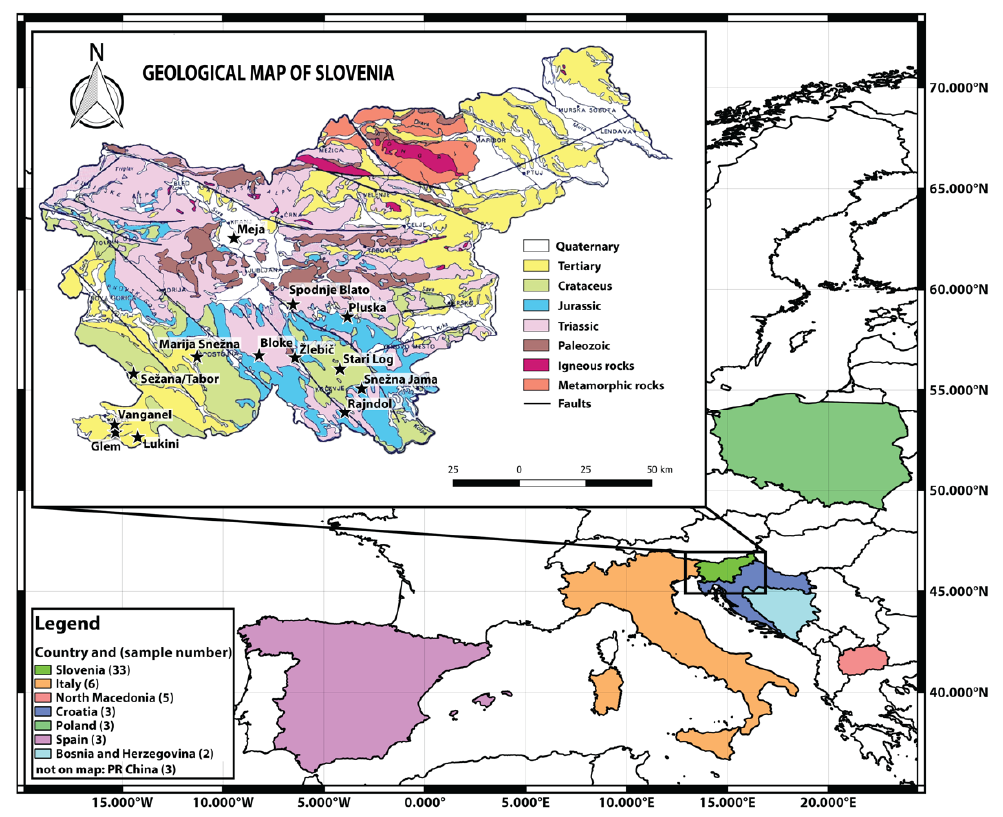
Figure 9. Geologic map of Slovenia (GeoSZ, 2013) with sample sites from the dataset (Table S1, Supplementary Material) marked as black stars. In the background are colored European countries with marked natural sites where truffles were collected: Italy, North Macedonia, Croatia, Poland, Spain, and Bosnia and Herzegovina. Only samples from China were purchased on the market.